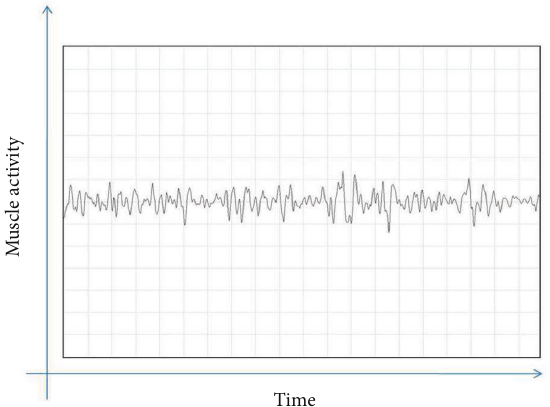
Figure 4: Electromyography recording of OSMF patients after